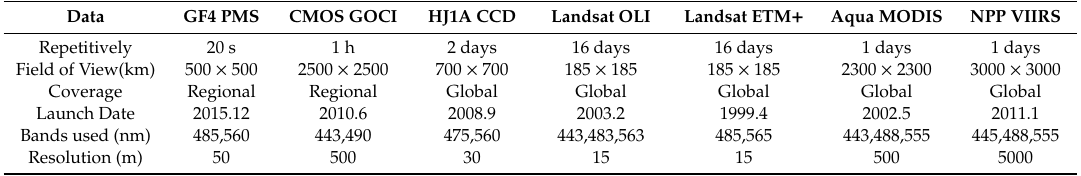
Table 1. Summary of characteristics of different sensors used in the present study.